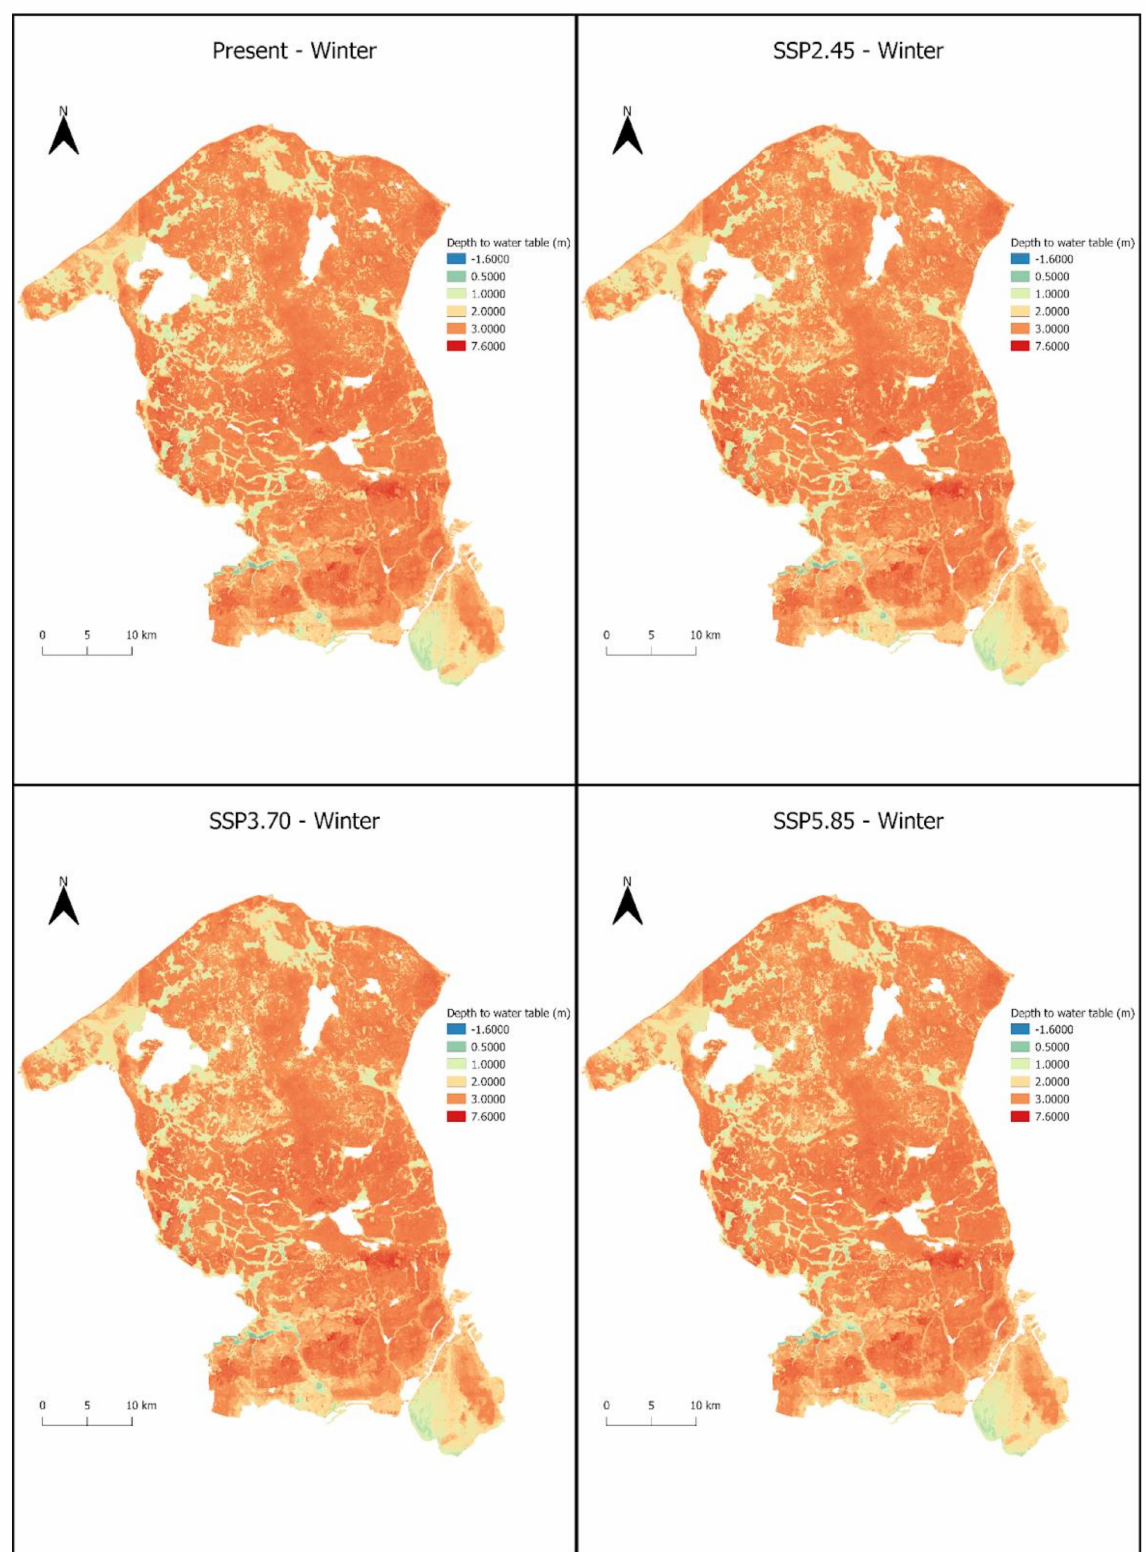
Figure A2. Comparison of the resulting maps based on the predictions made with the RF model for the different climate change scenarios, for the winter season. The maps show the depth to the water table in meters, where negative values represent water over the surface of the terrain, and positive values show the water table found under the